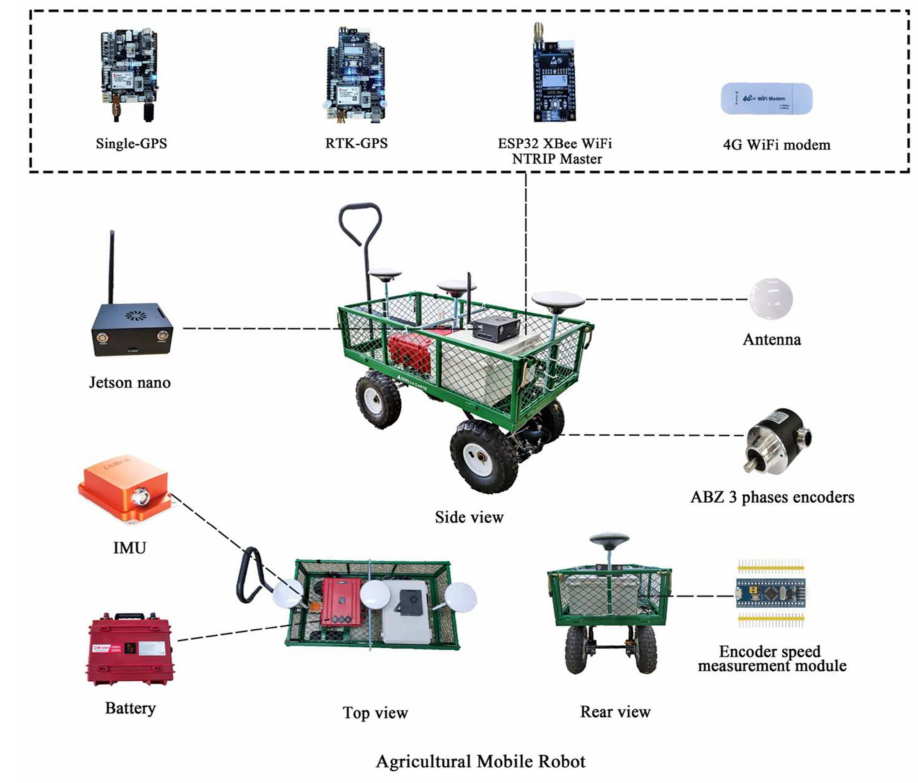
Figure 2. Assembled sensors and components of the